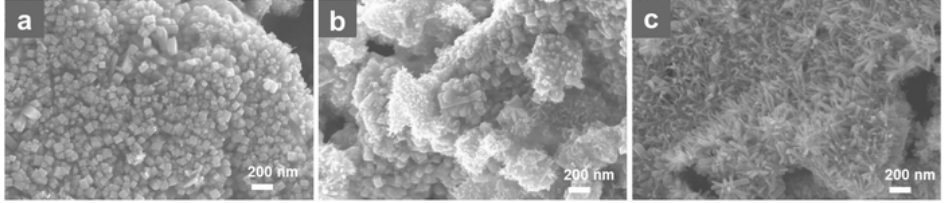
Figure 10. SEM image of the different IrO 2 nanostructures obtained through the molten salt method: ( a ) nanocubes, ( b ) mixture of nanocubes and nanorods, ( c ) nanorods (Reprinted/adapted with permission from Ref. [108]).